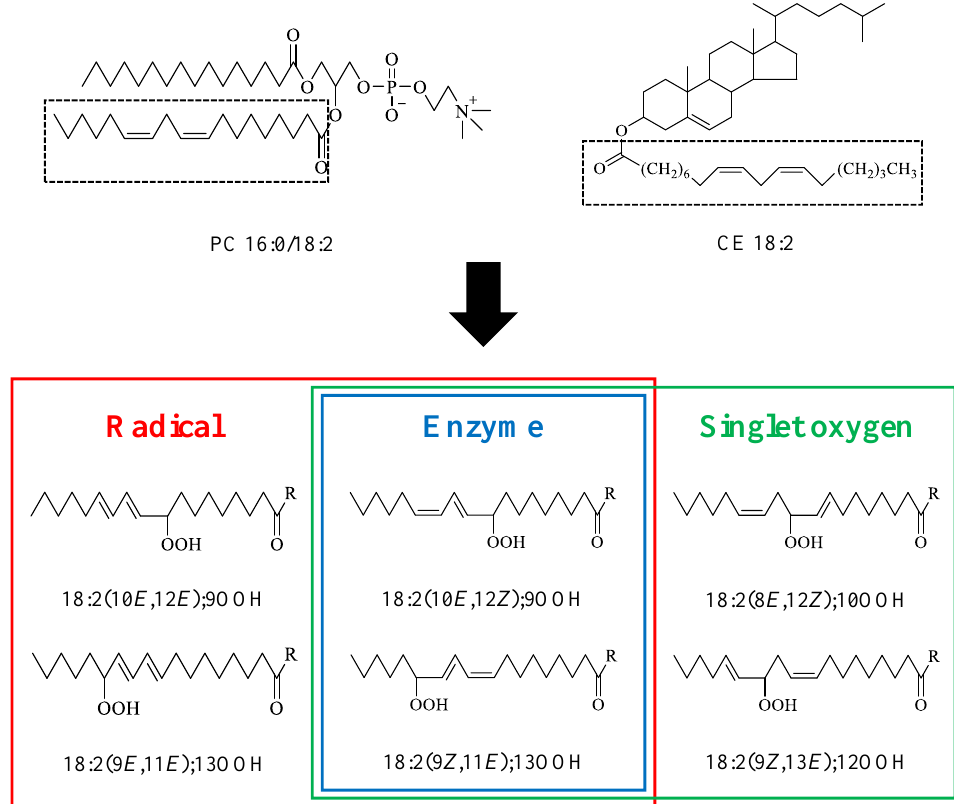
Figure 1. 1-Palmitoyl-2-linoleoyl- sn -glycero-3-phosphocholine (PC 16:0/18:2) and cholesteryl linoleate (CE 18:2) peroxidation mechanisms and the structures of their hydroperoxide isomers. PC 16:0/18:2 and CE 18:2 are oxidized to 1-palmitoyl-2-linoleoyl- sn -glycero-3-phosphocholine hydroperoxide (PC 16:0/18:2;OOH) and cholesteryl linoleate hydroperoxide (CE 18:2;OOH) isomers, respectively, by radical, enzymatic, and singlet oxygen ( 1 O 2 ) oxidation. Hydroperoxyl group position and geometrical structure depend on the peroxidation mechanisms. The shorthand notation of lipids was in accordance with LIPID MAPS (Liebisch, G. et al. J. Lipid Res. 2020 , 61 , 1539–1555 [8]), e.g., PC 16:0/18:2(10 E ,12 E );9OOH means 1-palmitoyl-2-(9-hydroperoxy-10 E ,12 E -octadecadienoyl)- sn -glycero-